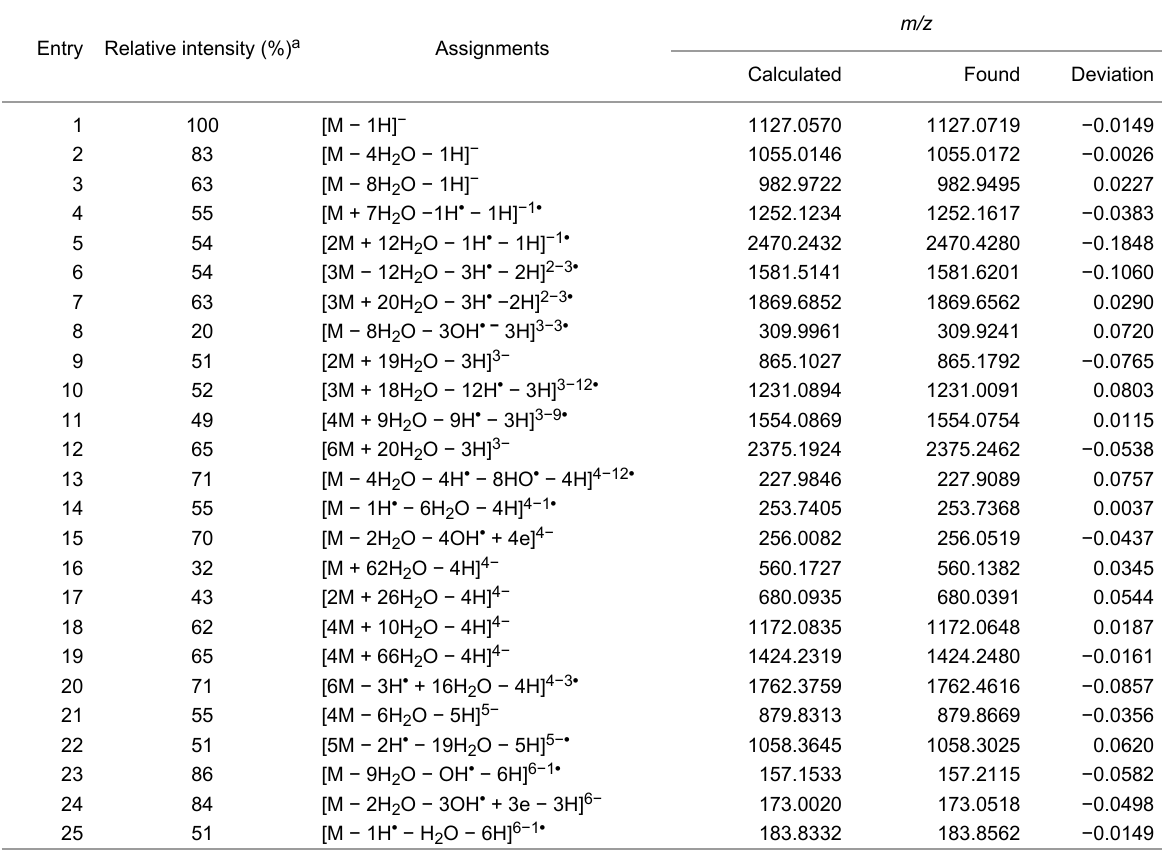
Table 1: Summary of the dominant ESI-MS negative ionic species of fullerenol C 60 (OH) 24 in ultrapure water (relative abundance, assignments, and m / z values) at 4.5 kV capillary voltage and 400 V fragmentor voltage.